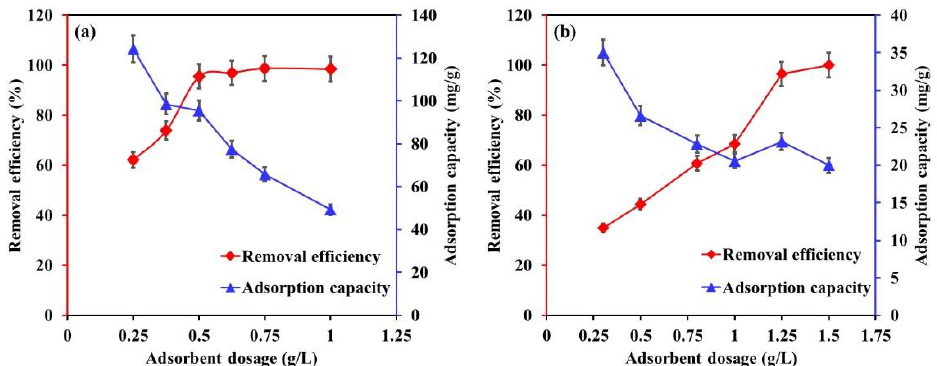
Figure 7. The influence of Mg-Ca-Al-LDO composite dosage on the removal efficiency and adsorption capacity of ( a ) EBT and ( b ) Cr. [EBT] i = 50 mg/L; [Cr] i = 30 mg/L; temperature, 22 °C; contact time, 24 h; [pH] i , EBT = 5.2, [Cr]= 6.